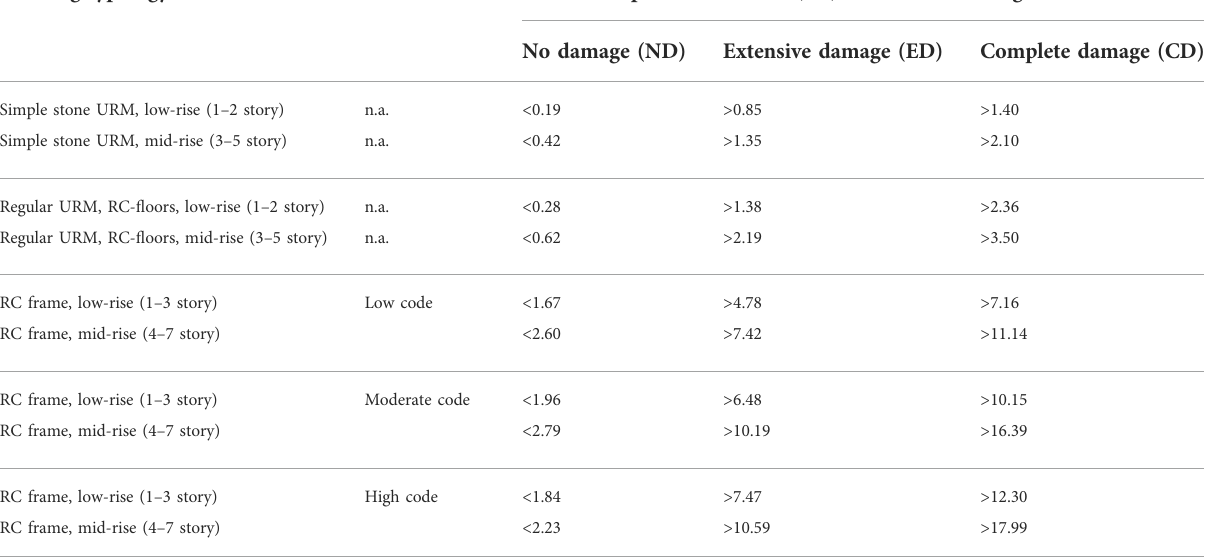
TABLE 1 Relative displacement limits (in centimeters) for selected building typologies according to Lagomarsino and Giovinazzi